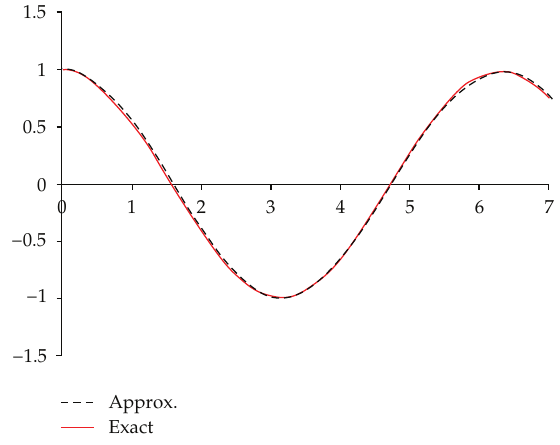
Figure 4: A comparison between the analytical solution and our approximated solution for k (cid:8) 0 .